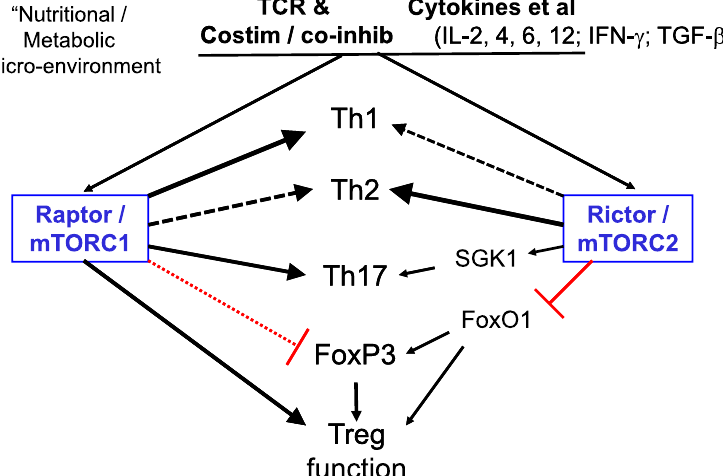
Figure 3. Over-simplified and more literature-based pictures of mTOR regulation of the acquired functions of mature CD4 + T-cells. ( A ) An oversimplified view segregating functions of mammalian (or mechanistic) target of rapamycin (mTOR) complexes with distinct functions mapping one on one with T helper (Th) subsets. ( B ) A partial integration of more complete information as represented in the cited articles 51–53,57–59,79–83 and related work. Notable differences include that, presumably as a function of differences in conditions, the literature supports roles for each mTOR complex in promoting each of the peripherally acquired CD4 effector phenotypes (Th1, Th2, Th17), while the effects on regulatory T (Treg) are complex, with mTOR and mTORC2 shown to restrain induction of FoxP3 52,53 but mTORC1 vital for the suppressive function of these cells 83 . If non-drastic decreases in nuclear FoxO1 are assumed to attenuate Treg function 59 , then enhanced mTORC2 activity in Treg might decrease their inhibitory properties. The connection of mTORC2 to Th17 function is inferred from mTORC2 activation of SGK1 and the function of this latter factor in promoting pathogenic Th17 46 . Abbreviations: IFN- γ , interferon-gamma; IL, interleukin; RA, retinoic acid; TCR, T-cell receptor; TGF- β , transforming growth